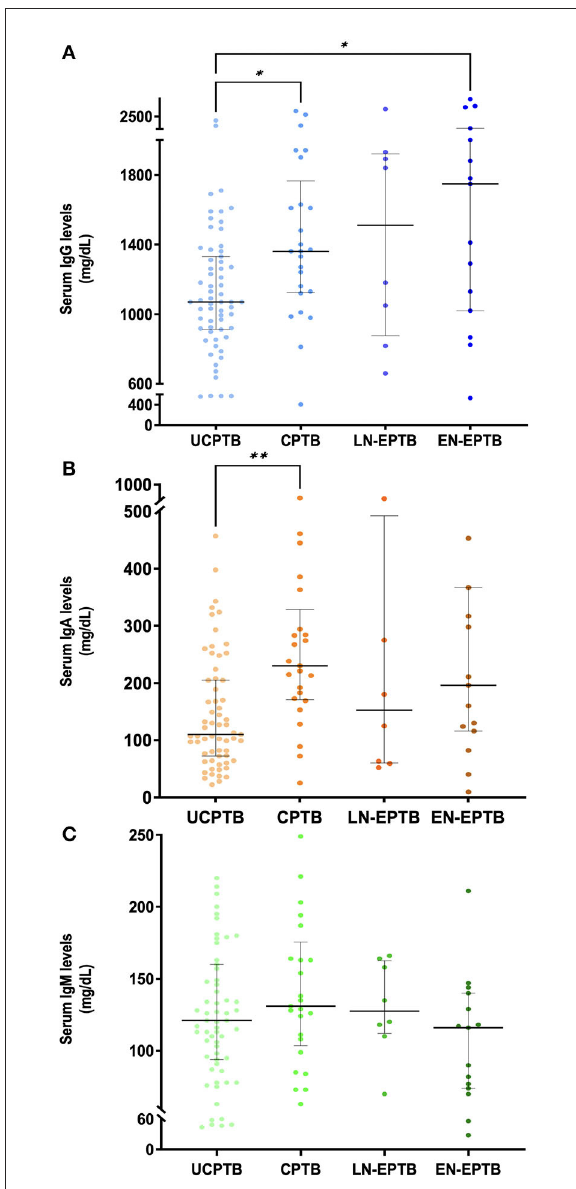
FIGURE1 Serum Ig levels at diagnosis in patients with TB disease. (A) IgG, (B) IgA, and (C) IgM levels were screened at diagnosis in 111 patients, divided into the four groups, namely, UCPTB ( n = 63), CPTB ( n = 25), LN-EPTB ( n = 8), and EN-EPTB ( n = 15), according to TB severity and extent. Colored dots with different shades were employed to distinguish patients belonging to different TB groups. Kruskal-Wallis test was used to assess differences among the four TB study groups ( * p < 0.05, ** p < 0.01). Black horizontal bars indicate median levels, while vertical lines indicate interquartile range (IQR). Ig, immunoglobulins;